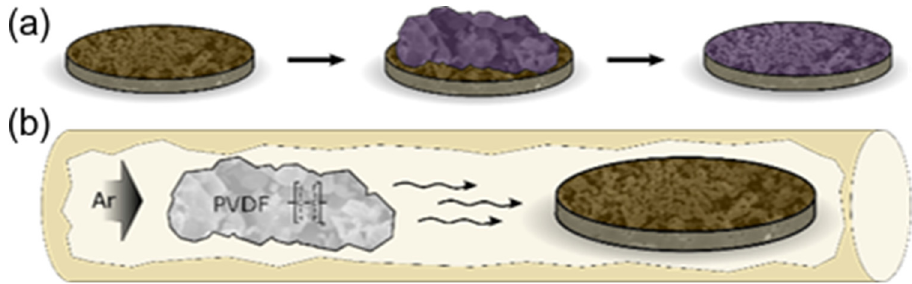
Figure 3. Topochemical fluorination of oxidic films to achieve ( a ) partial fluorinated BaFeO 2.33 F 0.33 |YSZ8|BaFeO 2.33 F 0.33 via an interdiffusion approach and ( b ) fully fluorinated BaFeO 2 F|YSZ8|BaFeO 2 F via the vapor transport related technique.